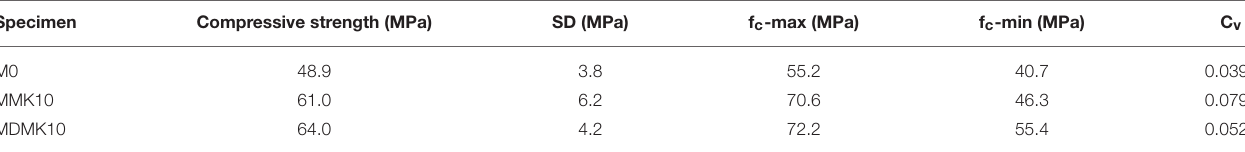
TABLE 9 | Average value, standard deviation, range, and coefficient of deviation of compressive strength at 28 days by calculating 18 specimens.